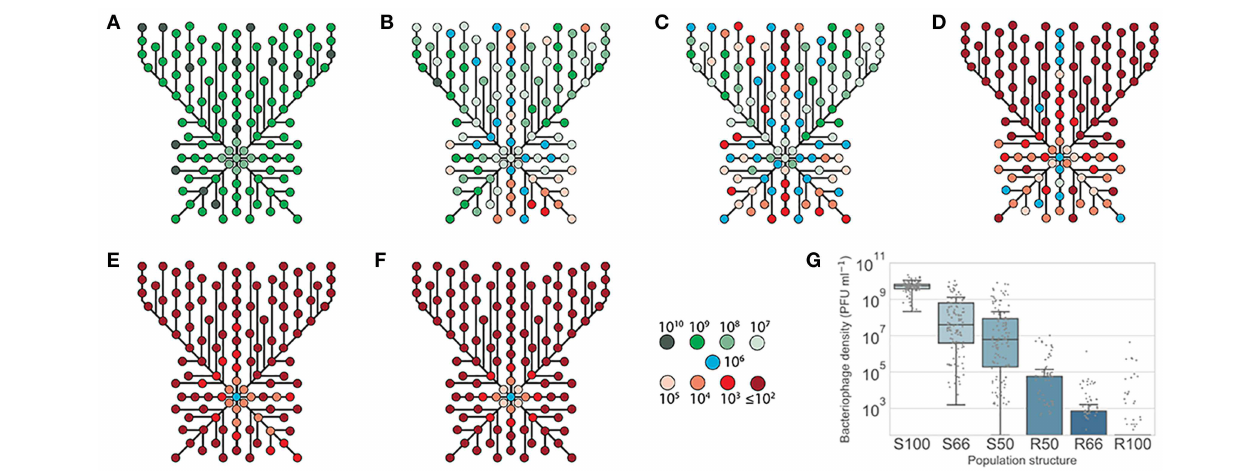
FIGURE 5 | Phage survival in spatially-structured sub-populations of lic2A phase variants of H. influenzae . Phage HP1c1 was passaged through a two-dimensional array of phage-resistant (R) and phage-susceptible (S) populations as indicated in Figure 1B . The proportion of phage susceptible sub-populations ( lic2A ON) in each fixed area structure were as follows: (A) 100% lic2A ON (S100); (B) 66% lic2A ON (S66); (C) 50% lic2A ON (S50); (D) 50% lic2A ON (R50); (E) 33% lic2A ON (R66); and (F) 0% lic2A ON (R100). Each node represents a well for which the phage titer was measured. The color of each node indicates the titer of bacteriophage detected in a specific well. Lines indicate the route taken starting from a central initiator well with line length being proportional to the number of cycles between each node. All central initiator wells were inoculated with 10 6 PFU/mL. (G) Shows a box-plot of the distribution of phage densities for each tested well of the fixed-area oscillating prey assays. Densities of phage (PFU/mL) obtained from each test well are represented by a dot for the six distributions of lic2A phase variants (x-axis). The boxed area indicates the first to third quartile, the line is the median of all points, and whiskers represent 1.5x the interquartile range. Due to the nature of the small-drop plating methodology employed for phage enumeration the minimum detection threshold at any time point is 3.3 × 10 1